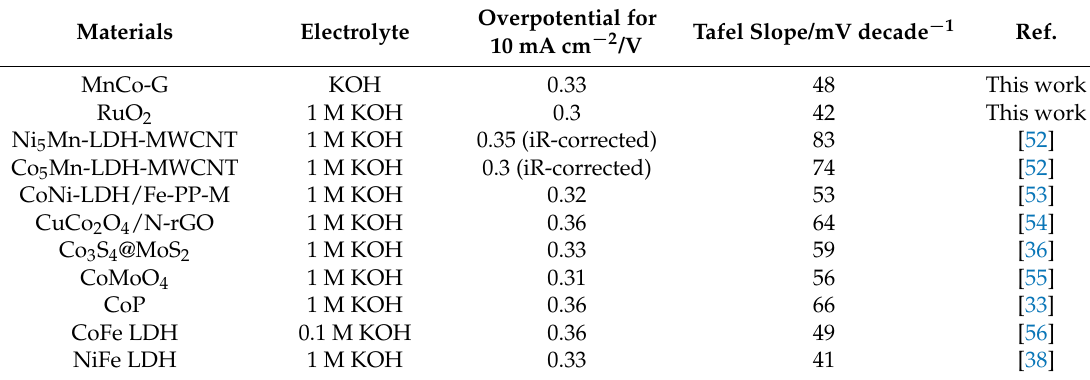
Table 1. Comparison of oxygen evolution reaction (OER) performance with various transition metal oxide and hydroxide.